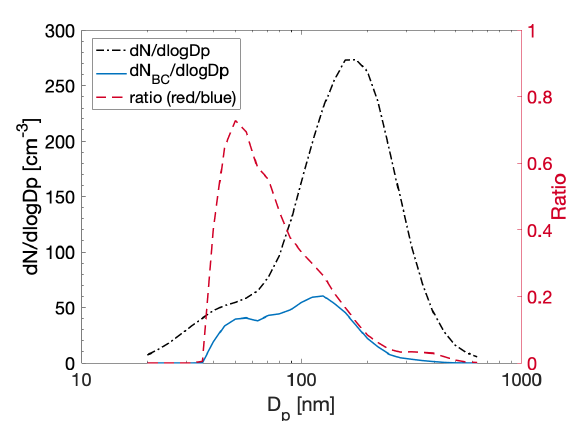
Figure A4. Adapted from Figure 8 in [19]. Median observed particle size distribution dN/dlogD p (black dash-dotted) and median inferred dN eBC /dlogD p (blue solid) over the particle size. Ratio between the two curves (dN eBC /dlogD p / dN/dlogD p ) is shown in the red dashed line on the secondary